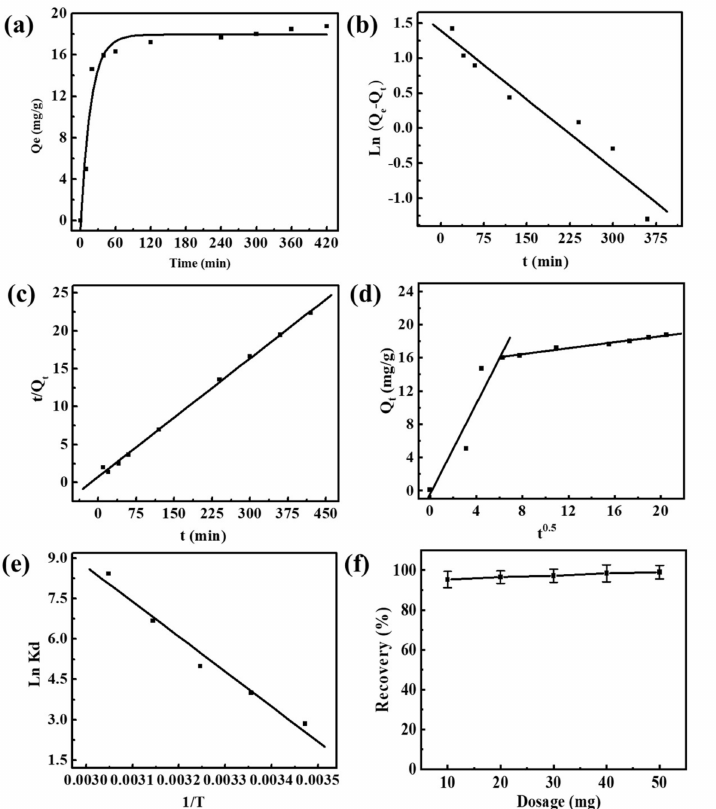
Figure 7. ( a ) Effect of time on adsorption amount of cesium ions (C 0 = 40 mg/L; pH = 5.5; m = 30 mg; V = 20 mL; T = 293 K); ( b ) pseudo-first-order reaction fit of cesium ion sorption kinetics by MPBNs; ( c ) pseudo-second-order reaction fit of cesium ion sorption kinetics by MPBNs; ( d ) the intraparticle diffusion reaction fit of cesium ion sorption kinetics by MPBNs; ( e ) Arrhenius plot for cesium ion adsorption by MPBNs; ( f ) effect of dosage for the recovery rate of MPBNs (C 0 = 40 mg/L; T = 293 K; pH = 5.5; V = 40 mL; t = 12